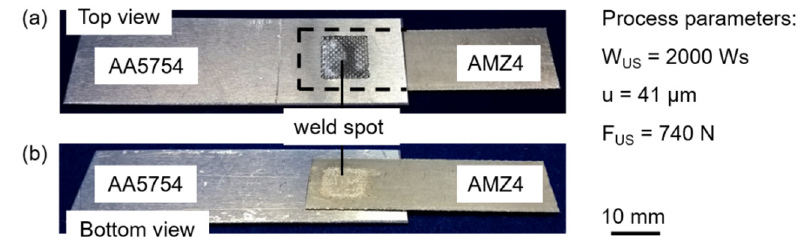
Figure 4. ( a ) Top view of a welded specimen showing a typical imprint of the sonotrode surface with the pyramidal profile. ( b ) Bottom view of a welded specimen showing a slight discoloration in the area of the weld spot. Process parameters: welding energy W US = 2000 Ws, displacement amplitude u = 41 µm and welding force F US = 740 N.